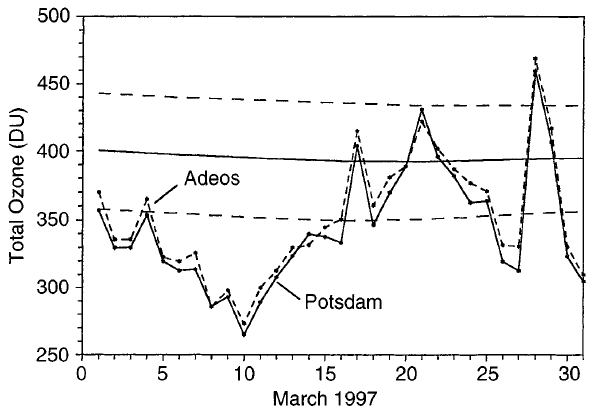
Fig. 6. March 1997 daily total ozone measurement at Potsdam ( solid ) in comparison with Adeos TOMS ( dashed ) measurements; linear interpolation of four gridpoint values nearest to Potsdam. Quasi- horizontal lines : long-term average of Potsdam values 1964–83 and (cid:139)1 standard deviation